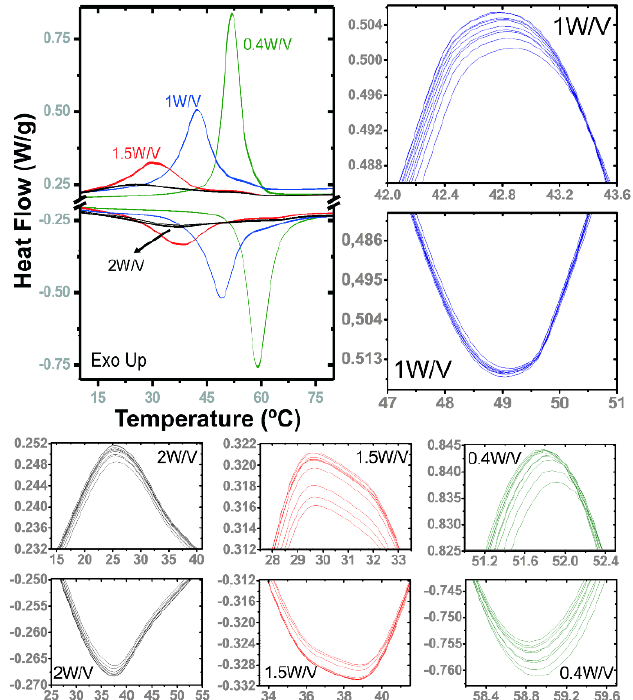
Figure 7. DSC plots of 10 cycles of heating and cooling applied to some representative samples of W/V tested compositions, with the detail of the top of the peaks in the same range of heat flow for comparison, demonstrating a high level of replication.